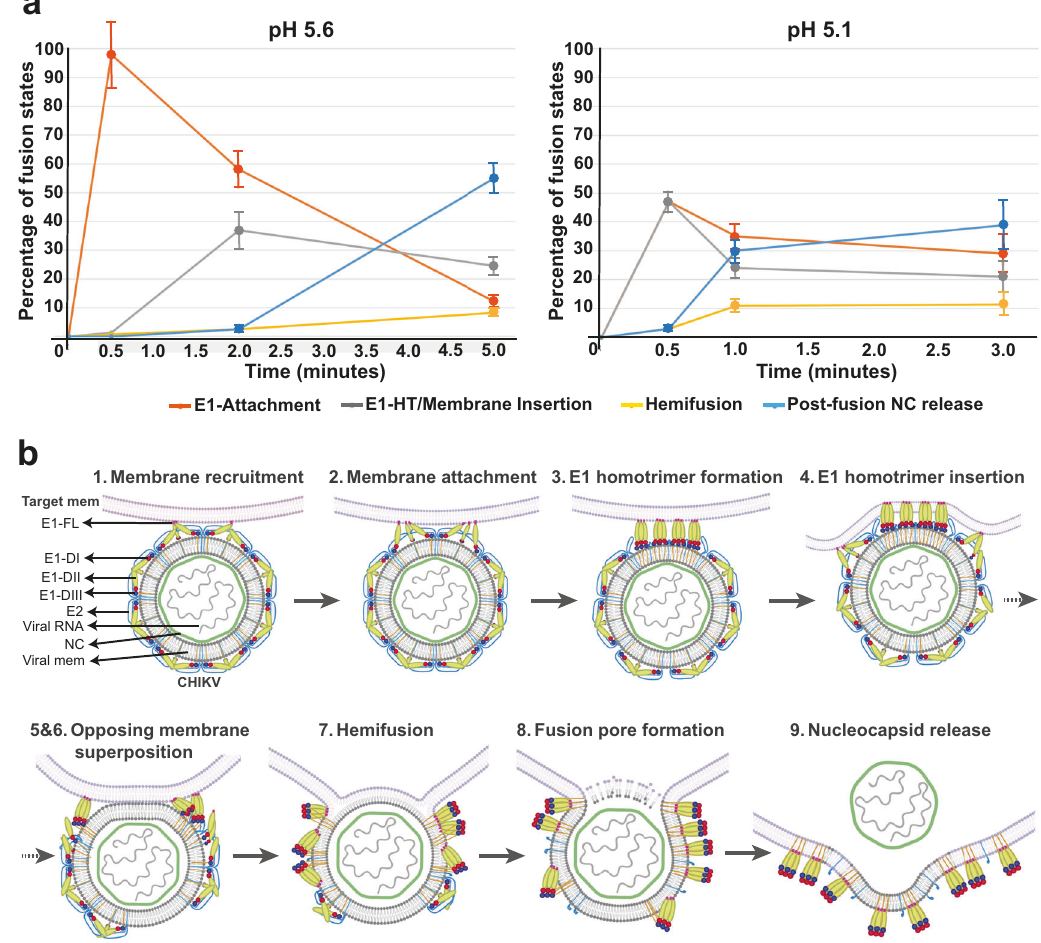
Fig. 6 | CHIKV membrane fusion pathway. a Population of fusion-states during CHIKV membrane fusion. For pH 5.6 (left) and pH 5.1 (right), percentage of each fusion-state was calculated as a function of the total number of CHIKV-liposome contacts(n)observedatthatgivenpHandtimepoint.ForpH5.6, n =281andforpH 5.1, n =263.E1attachment(redplotline)includesstagesI(membranerecruitment) andII(membraneattachment);E1-HT/MembraneInsertion(grayplotline)includes stage III-VI: E1-HT formation, E1-HT membrane insertion, membrane superposition